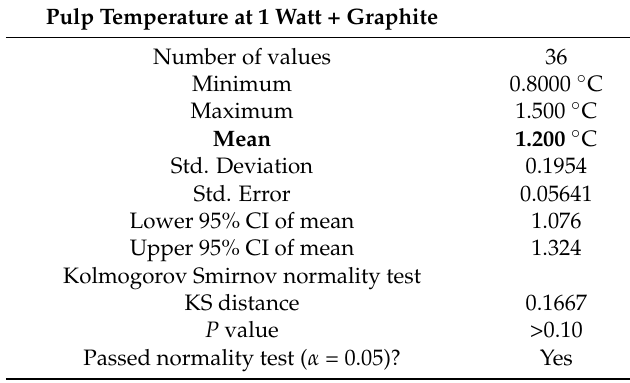
Table 3. Pulp temperature increase following diode laser (980 nm) irradiation with graphite paste.